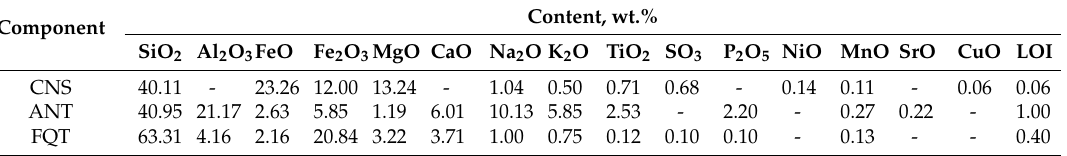
Table 1. Chemical composition of the ceramic charge